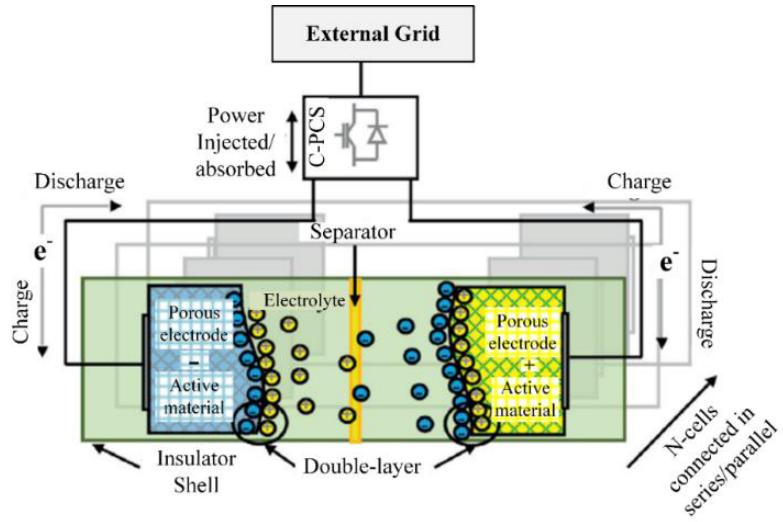
Figure 14. Schematic diagram of a conventional capacitor storage system connected to the external grid trough a converter [37,54].